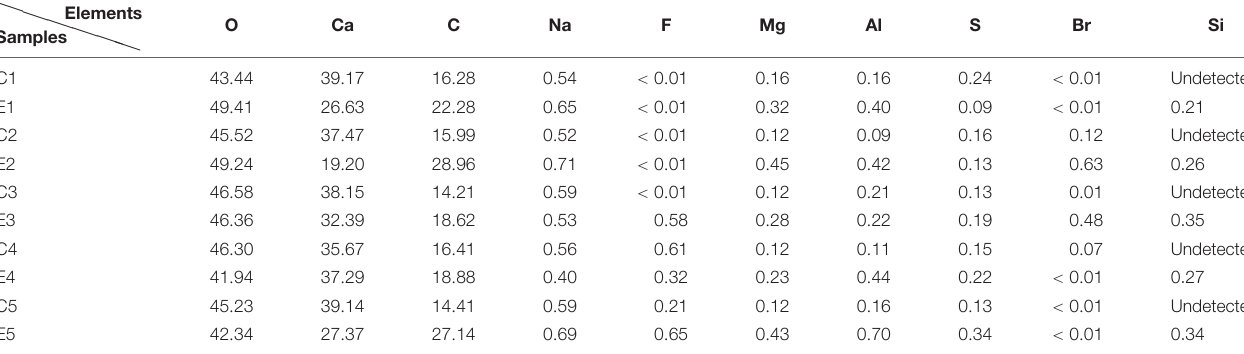
TABLE 1 | SEM-EDS results of the inner surfaces of normal shells and shells with spots.